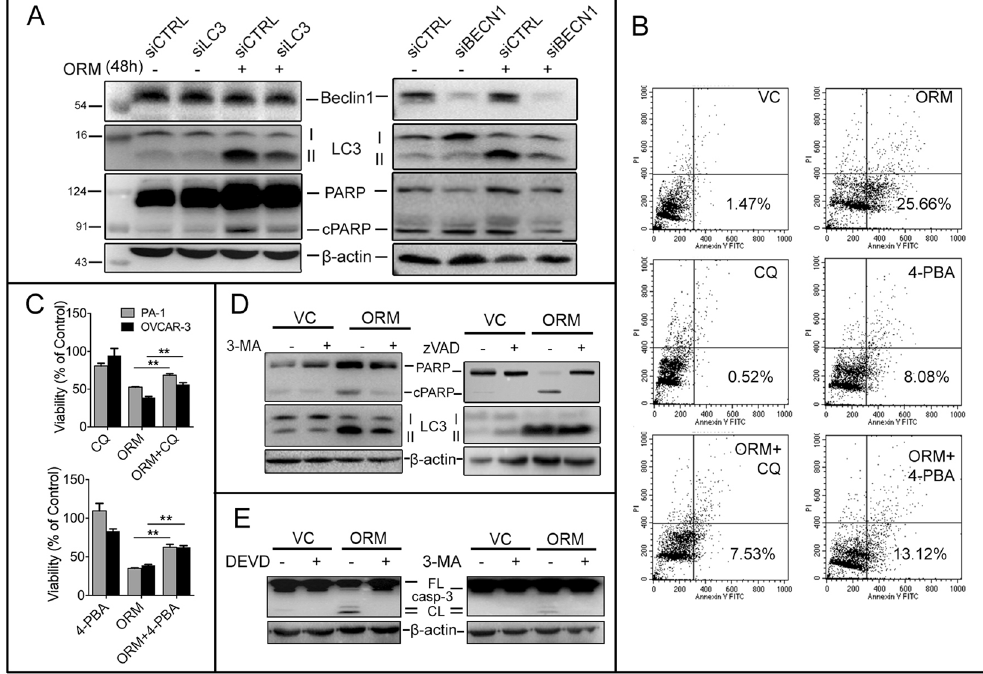
Figure 4. ORM-induced autophagy is upstream of apoptosis and pro-death in nature. ( A ) PA-1 cells were transfected for siRNA against either LC3 or Beclin 1, two critical autophagy proteins and cellular levels of LC3-II and cPARP were observed as markers of autophagic and apoptotic activity. ( B) PA-1 cells were treated with ORM alone (IC 50 dose), or pre-treated with lysosomal fusion inhibitor chloroquine (CQ; 10 μ M, 2 h) or chemical chaperone and UPR inhibitor 4-PBA (5 mM; 2 h) before ORM treatment, stained with Annexin V-FITC/PI and analyzed by flow cytometry to assess apoptotic cell death (lower right quadrant = %early apoptotic population). ( C ) Viability (percentage of control) of PA-1 and OVCAR-3 cells pre-treated with CQ or 4-PBA and treated with ORM for 48 h measured through SRB assay; ( D , E ) PA-1 cells were pre-treated with 2.5 mM 3-MA or with 20 μ M z-VAD-fmk or with 20 μ M z-DEVD-fmk followed by 24 h ORM treatment (3-MA, z-DEVD) or 48 h ORM treatment (zVAD). PARP and LC3-II levels were analysed by